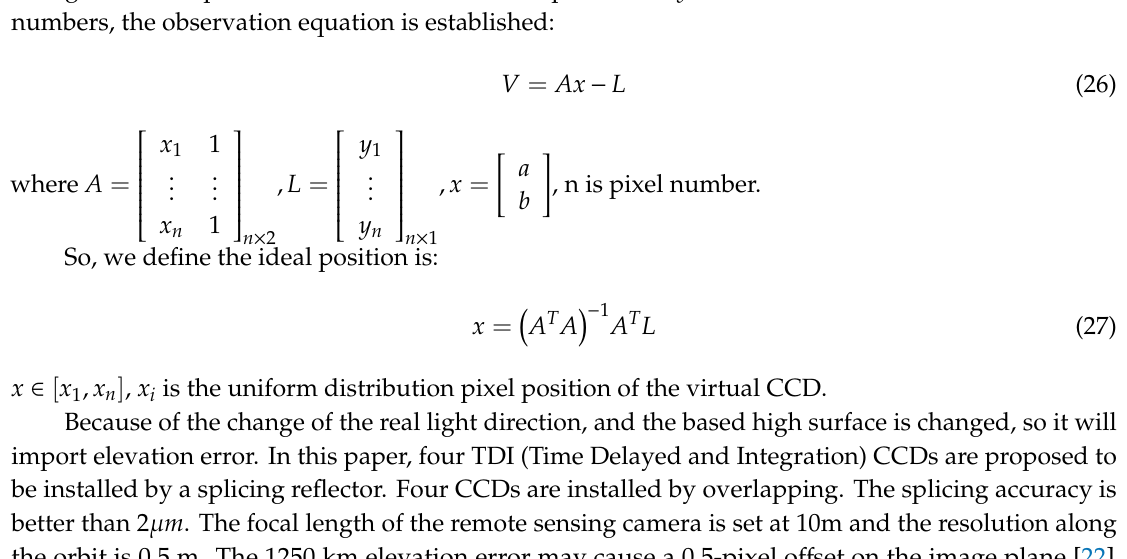
Figure 3. These quaternion data are used to calculate the star image from the virtual star camera. Star image is represented by 0~255 gray level, and gaussian white noise with zero mean is added as image